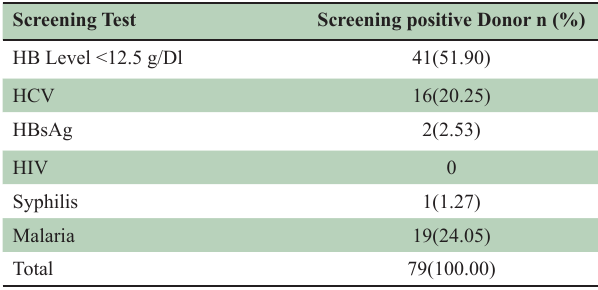
Table-II: Ratio Screening Testing Positive Blood donors.